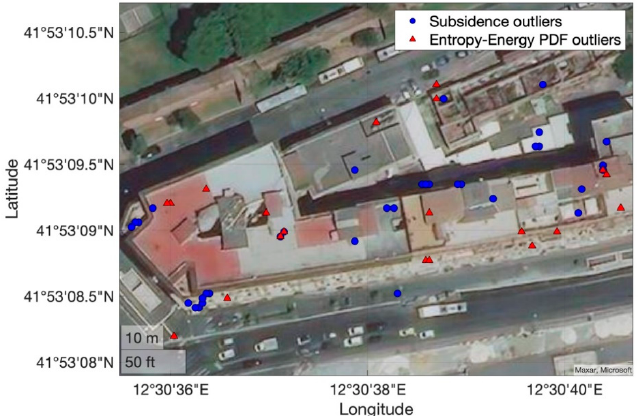
Figure 10. Map showing the experimental data for a building complex near San Giovanni station. The